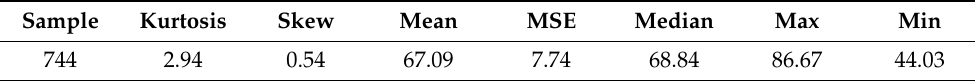
Table 1. Descriptive statistics of data.